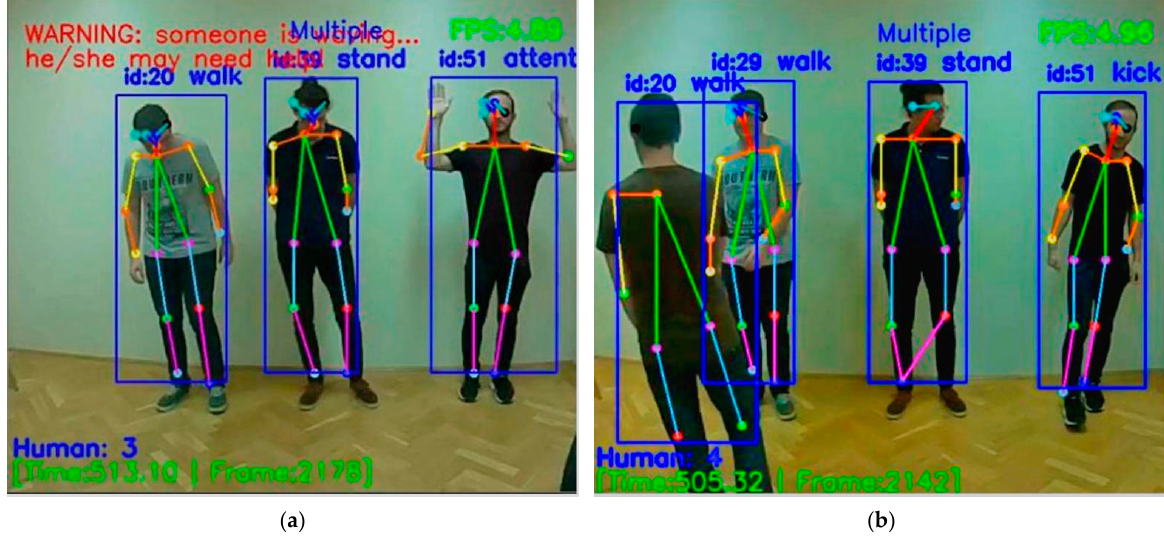
Figure 13. Multiple people with ( a ) and without ( b ) communication with UAV.